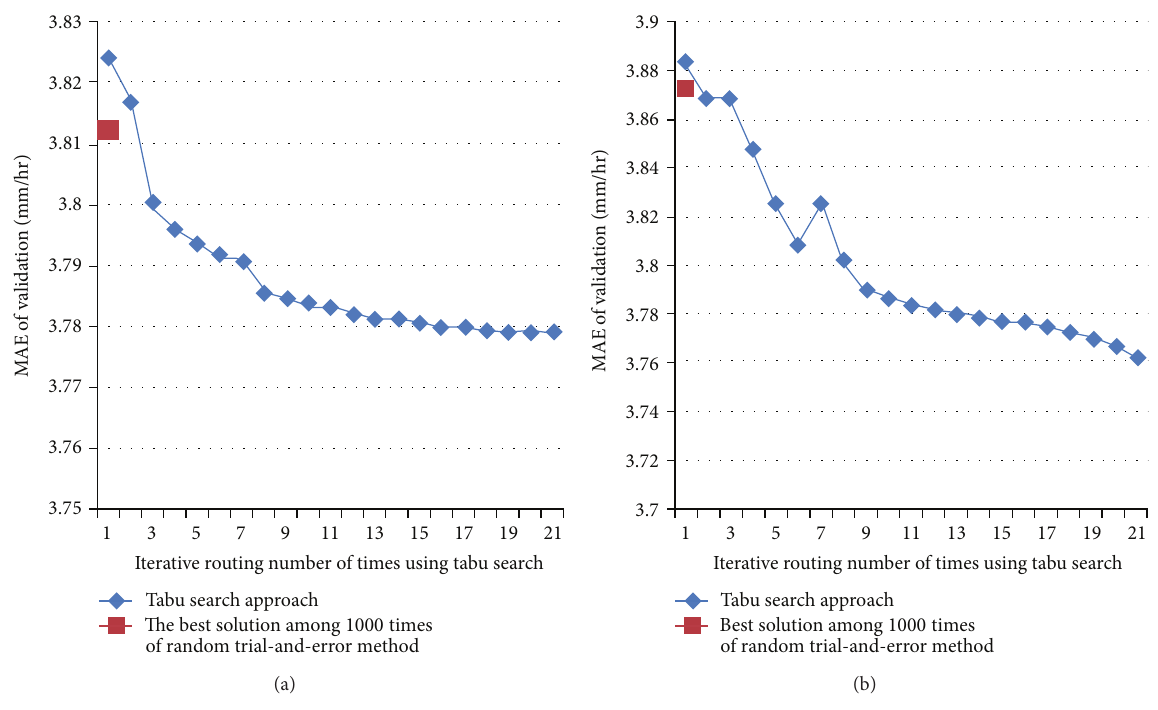
Figure 8: Comparison of MAE of validation between tabu search approach and random trial-and-error method for construction of ANFIS- based precipitation forecast model: (a) Yu-Feng station; (b) Hsia-Yun station.